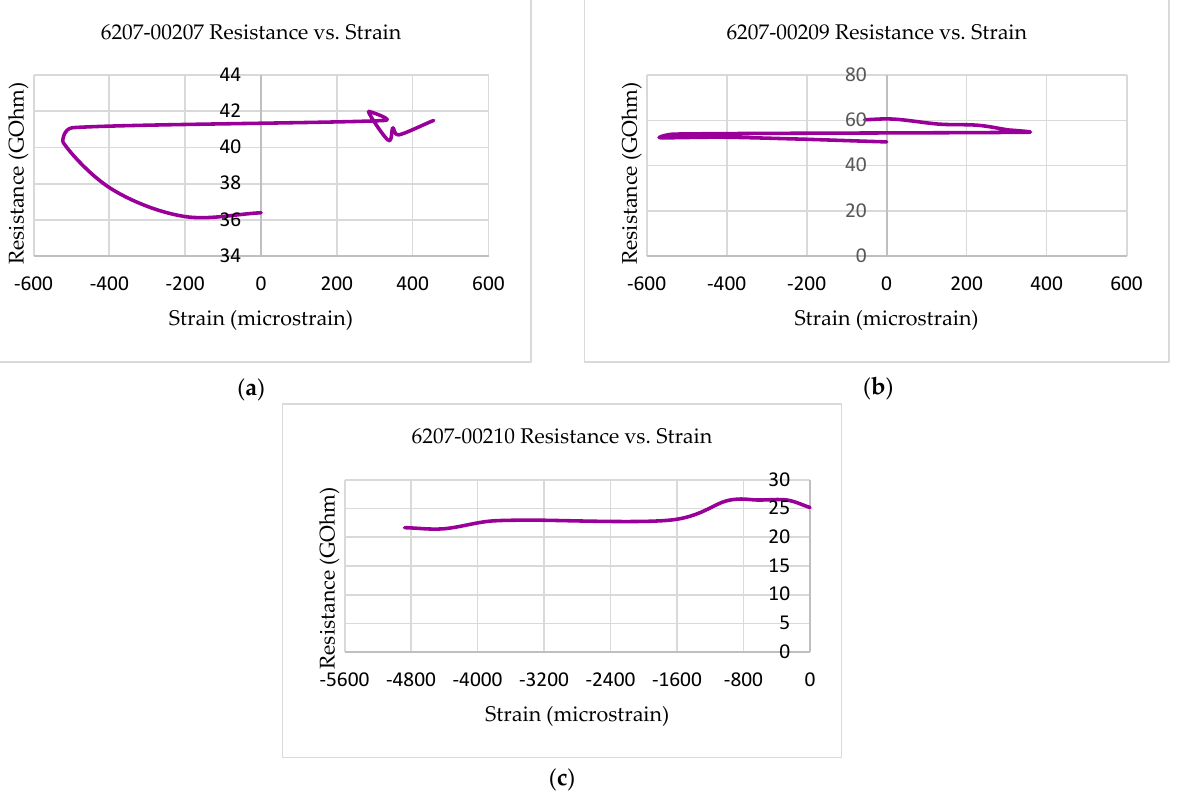
Figure 10. Multifunctional compressive ‐ electrical properties of test coupons at RTD: ( a ) 6207 ‐ 00207; ( b ) 6207 ‐ 00209; ( c ) 6207 ‐ 00210.